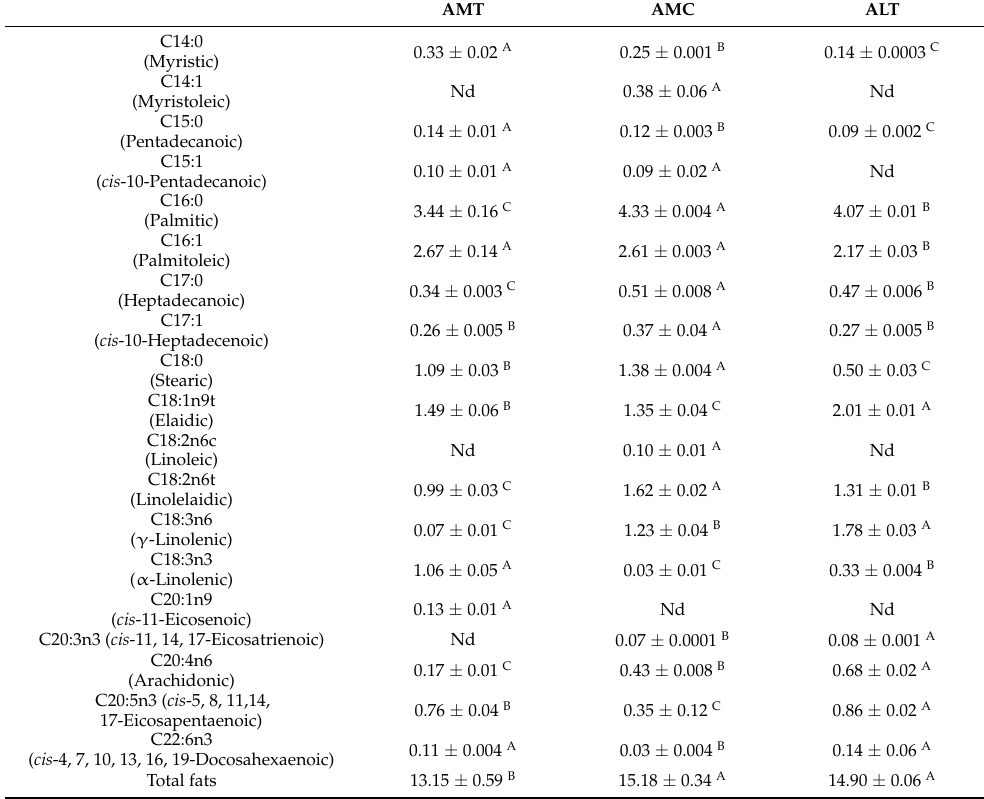
Table 5. Content of total fats and fatty acids in different Corixidae egg samples (g/100 g dry